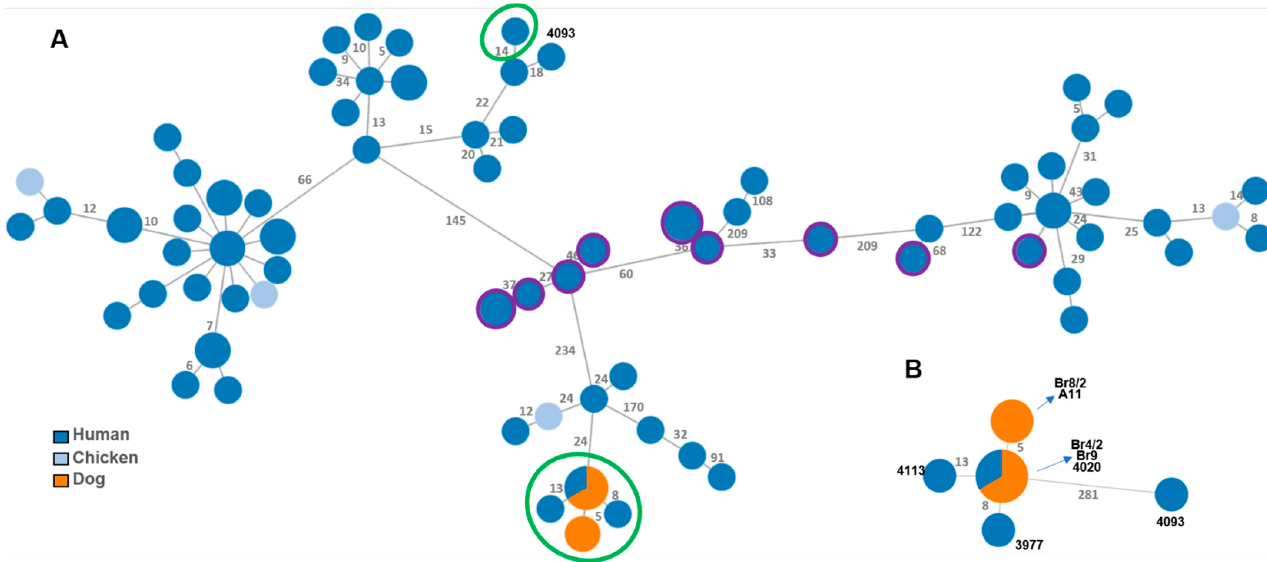
Figure 4. Phylogeny of Campylobacter jejuni ST-22 strains based on a dynamic gene-by-gene approach using a wgMLST schema with 2477 loci. ( A ) The initial MST was constructed based on the allelic diversity found among the 924 genes shared by 100% of the validated strains. Portuguese strains are marked with green circles: four from dogs (A11, Br8/2, Br4/2, Br9) and four from humans (3977, 4020, 4093, 4113); US strains are marked with purple outer rings; the remaining strains are from the UK. ( B ) Sub-MST reconstruction based on the allelic diversity found among the 953 genes shared by all validated PT strains (ID strains in bold). For both panels, trees were constructed using the goeBURST algorithm implemented in the PHYLOViZ Online platform. Filled circles (nodes) representing unique allelic profiles are colored according to strains’ source (human, chicken or dog). The size of nodes is proportional to the number of isolates it represents. The numbers in grey on the connecting lines represent the allele differences (AD) between strains. For better visualization, only AD ≥ 5 are